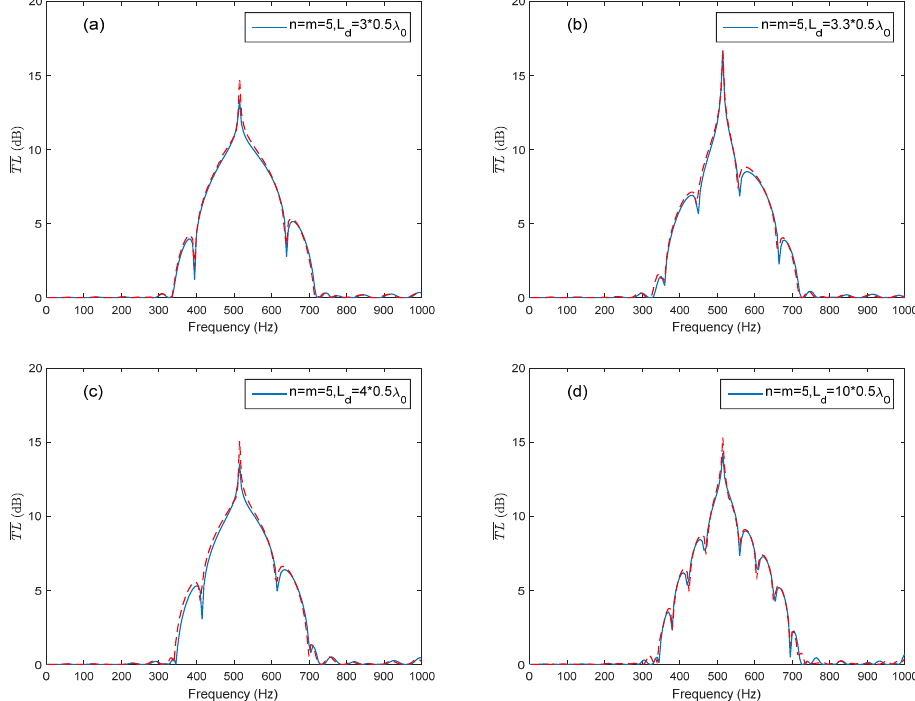
Figure 8. Comparison of theoretical predictions and the FEM simulation with respect to different connection tube lengths L d between the two periodic parts (solid lines represent the theoretical predictions, and dashed lines represent the FEM simulation results): ( a ) n = m = 5, L d = 3 × 0.5 λ 0 ; ( b ) n = m = 5, L d = 3.3 × 0.5 λ 0 ; ( c ) n = m = 5, L d = 4 × 0.5 λ 0 ; ( d ) n = m = 5, L d = 10 × 0.5 λ 0